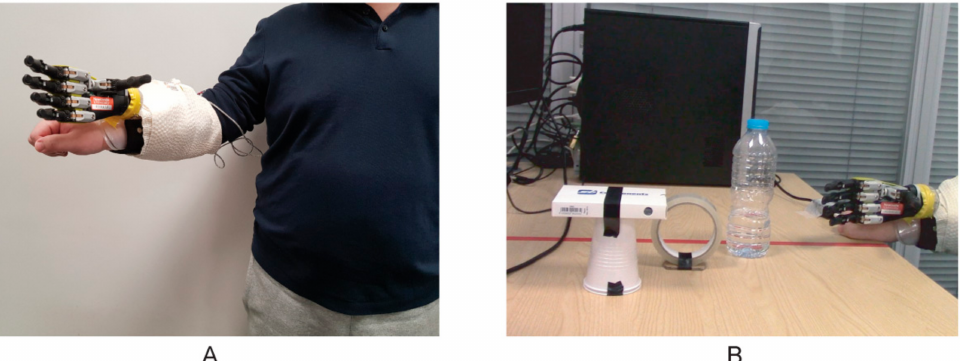
Figure 6. Pick-and-place experiments, ( A ) with a proband wearing the prosthetic hand attached by a special socket, ( B ) showing three objects which had to be grasped and relocated. From [108], originally published under a CC-BY